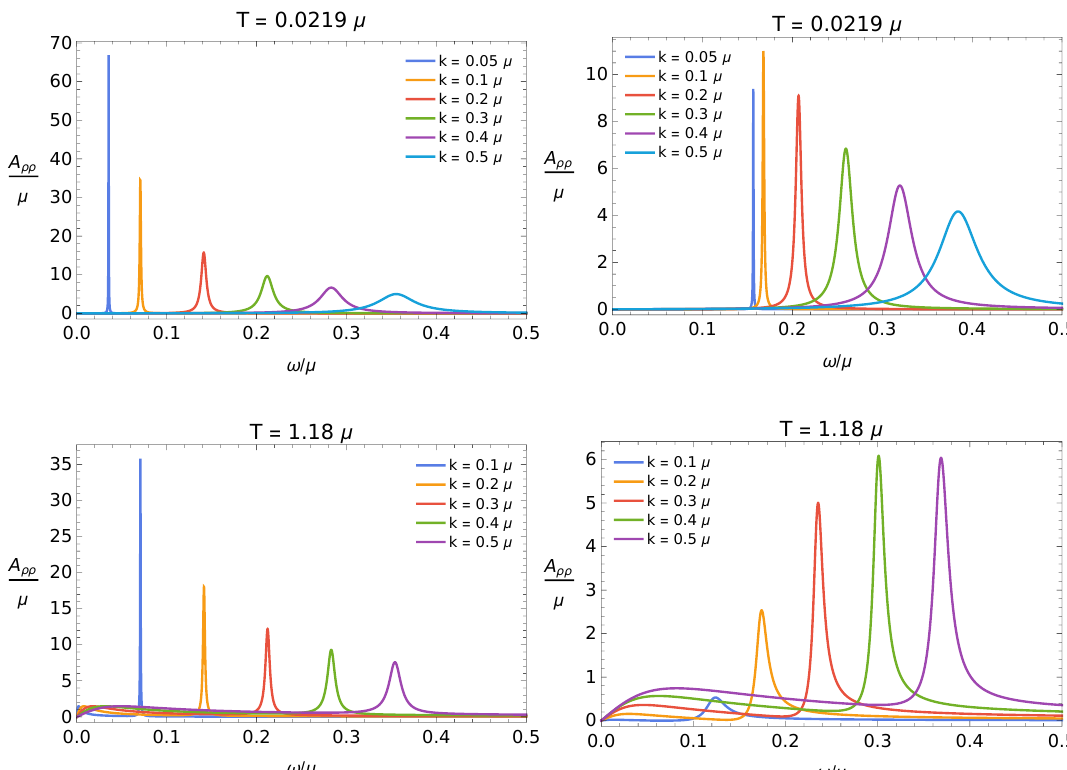
Figure 4. The density spectral function for T ’ 0 : 02 (cid:22) (top) and T ’ 1 : 18 (cid:22) (bottom) without (left) and with (right) double-trace deformation for di(cid:11)erent values of k=(cid:22) ( (cid:11) 2 = 1 = 25). We see that the height of the peak of the plasmon modes is lower than in the corresponding sound modes due to screening of the charged particles. Moreover we observe that for low momenta, the peak in the RPA response function decreases as we move towards smaller values of j k j =(cid:22)